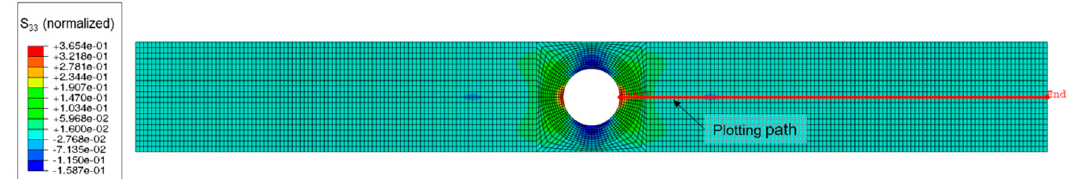
Figure A1. An example of unidirectional OHC coupon 2D FE mesh, contour plot of the normalized interlaminar normal stress component for the generic carbon/epoxy tape material and plotting path for verification of convergence of the stress field with mesh refinements.